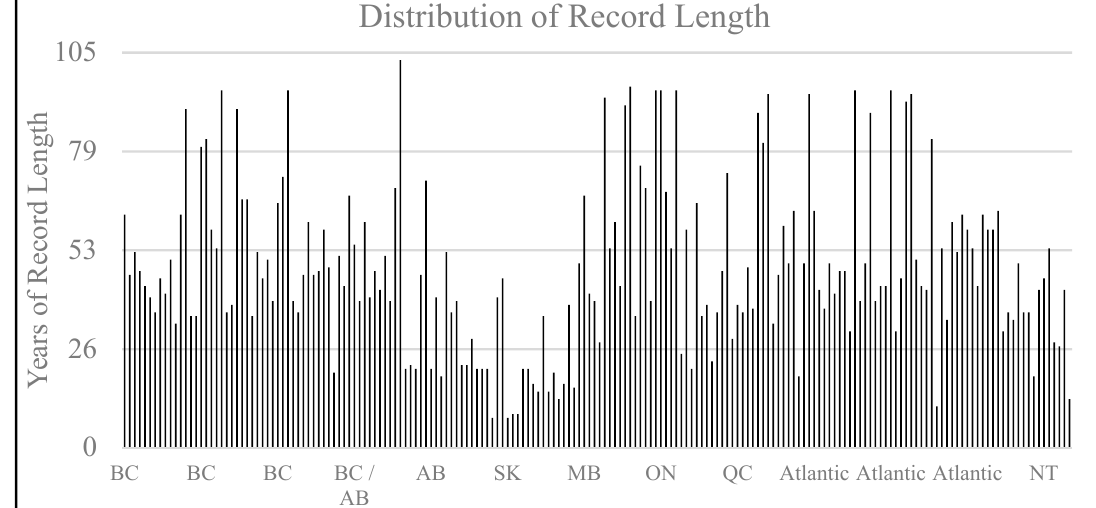
Figure 2. Distribution of record length for the 186 flood samples. Sites in the ten provinces are plotted in order of longitude from west (left) to east (right). Sites in the three territories are plotted to the right most of the figure, with three sites in northeast Qu é bec embedded within the Atlantic provinces.